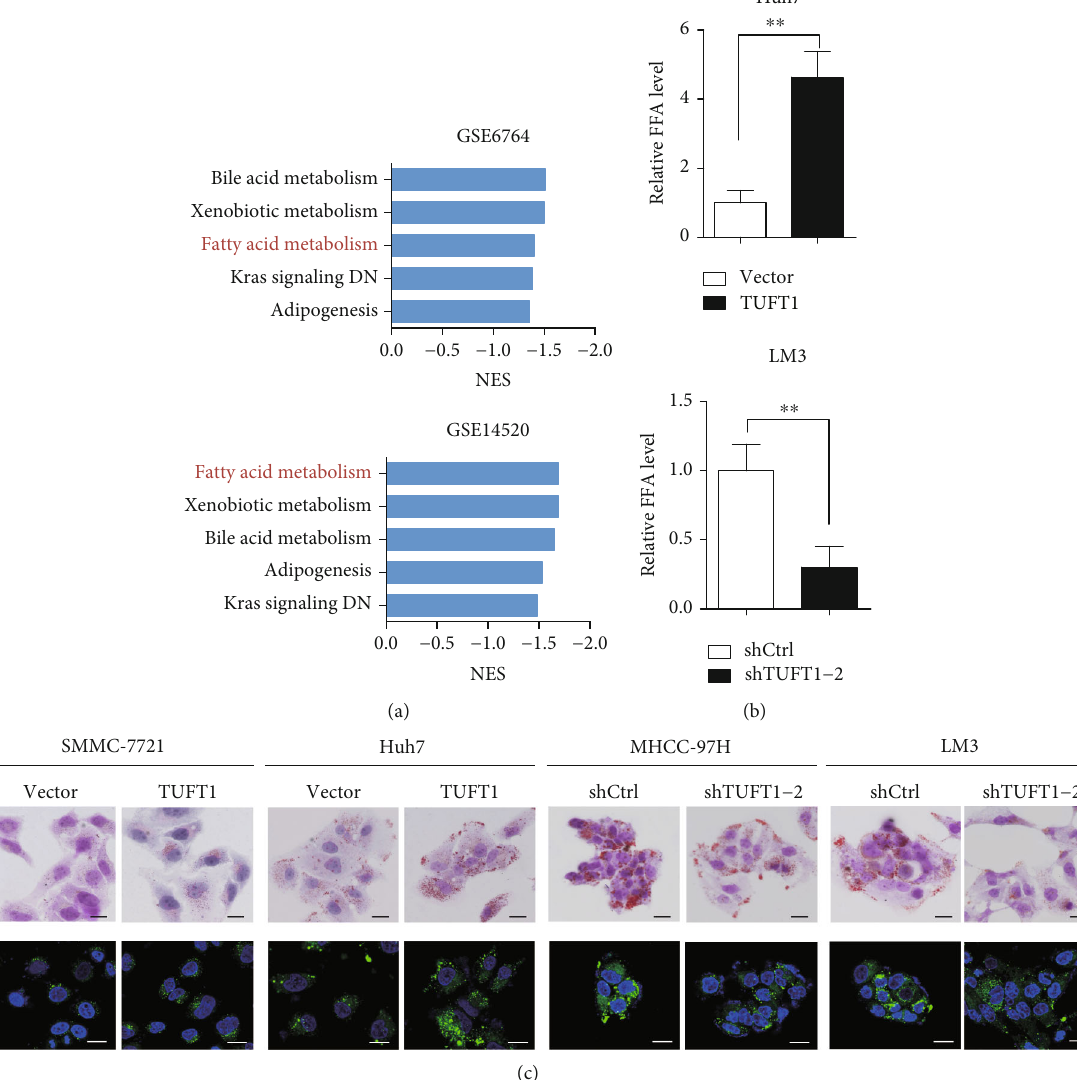
Figure 3: TUFT1 expression promoted lipid accumulation in HCC cells. (a) GSEA analysis showed that TUFT1 was involved in fatty acid metabolism. (b) Analysis of FFA level in TUFT1 overexpression or knockdown cells. (c) Lipid accumulation detected by oil red O and BODIPY 493/503 dye staining, in TUFT1 overexpression or knockdown cells. Scale bar: 10 μ